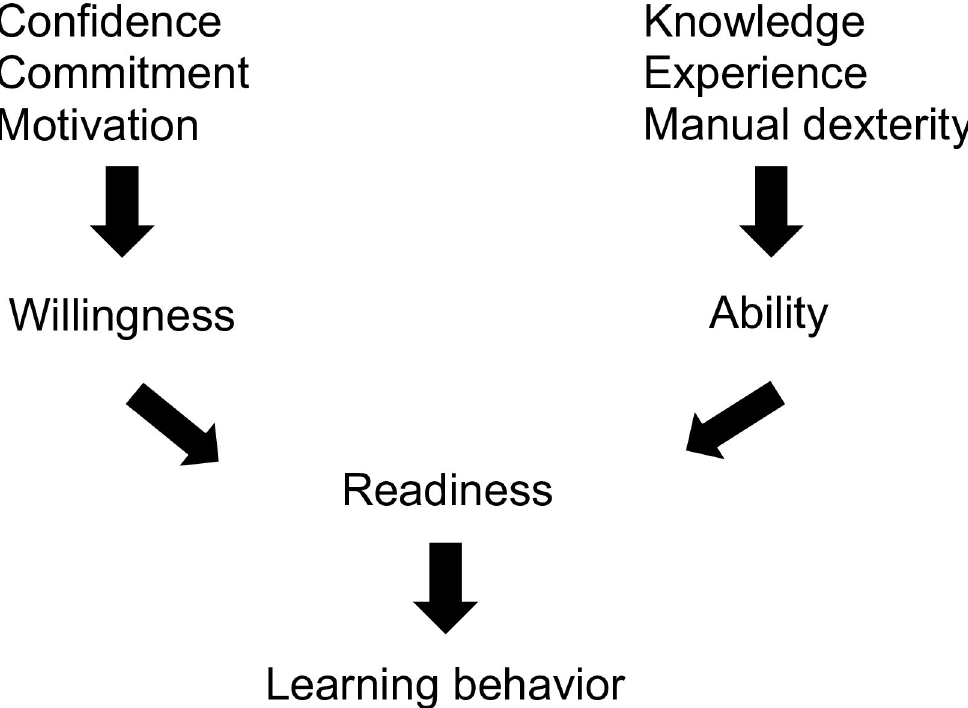
Fig 1. Learning behavior is determined by ability and willingness adapted from Hersey et al.’s Situational Leadership Theory [10,13].